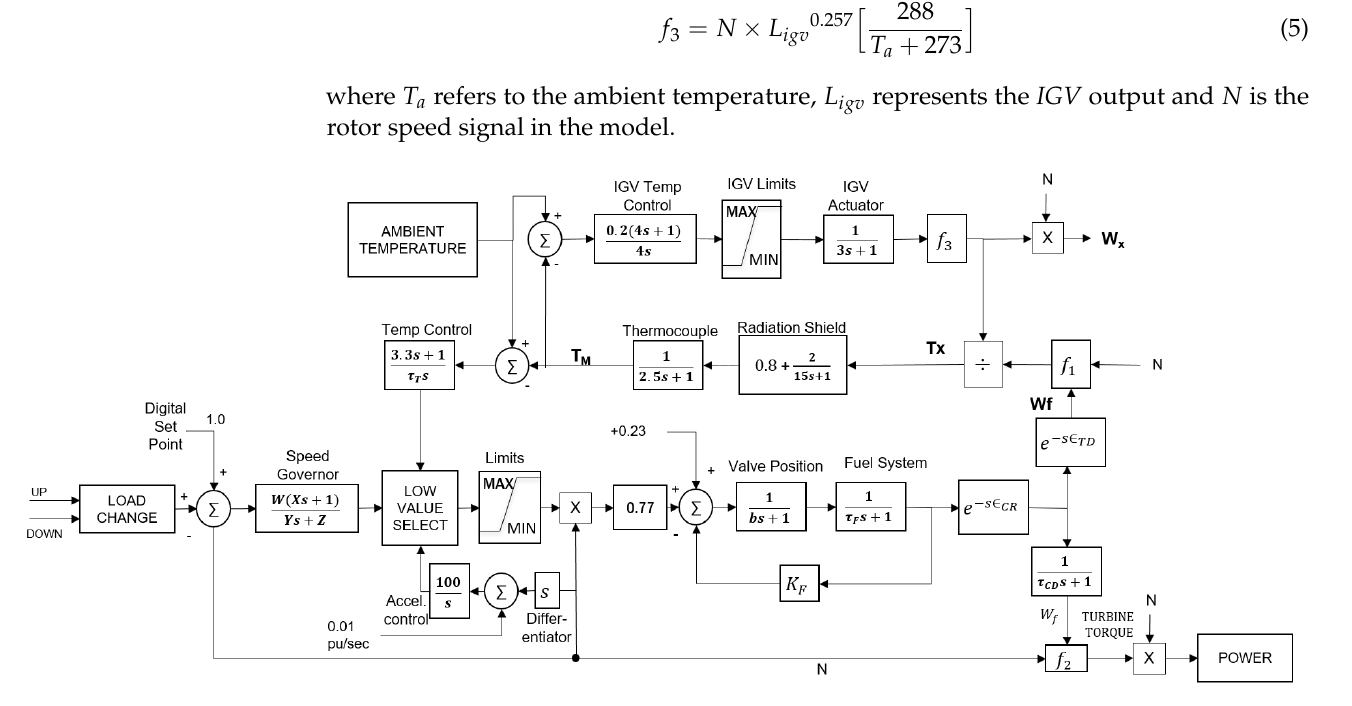
Figure 7. Rowen’s gas turbine dynamic